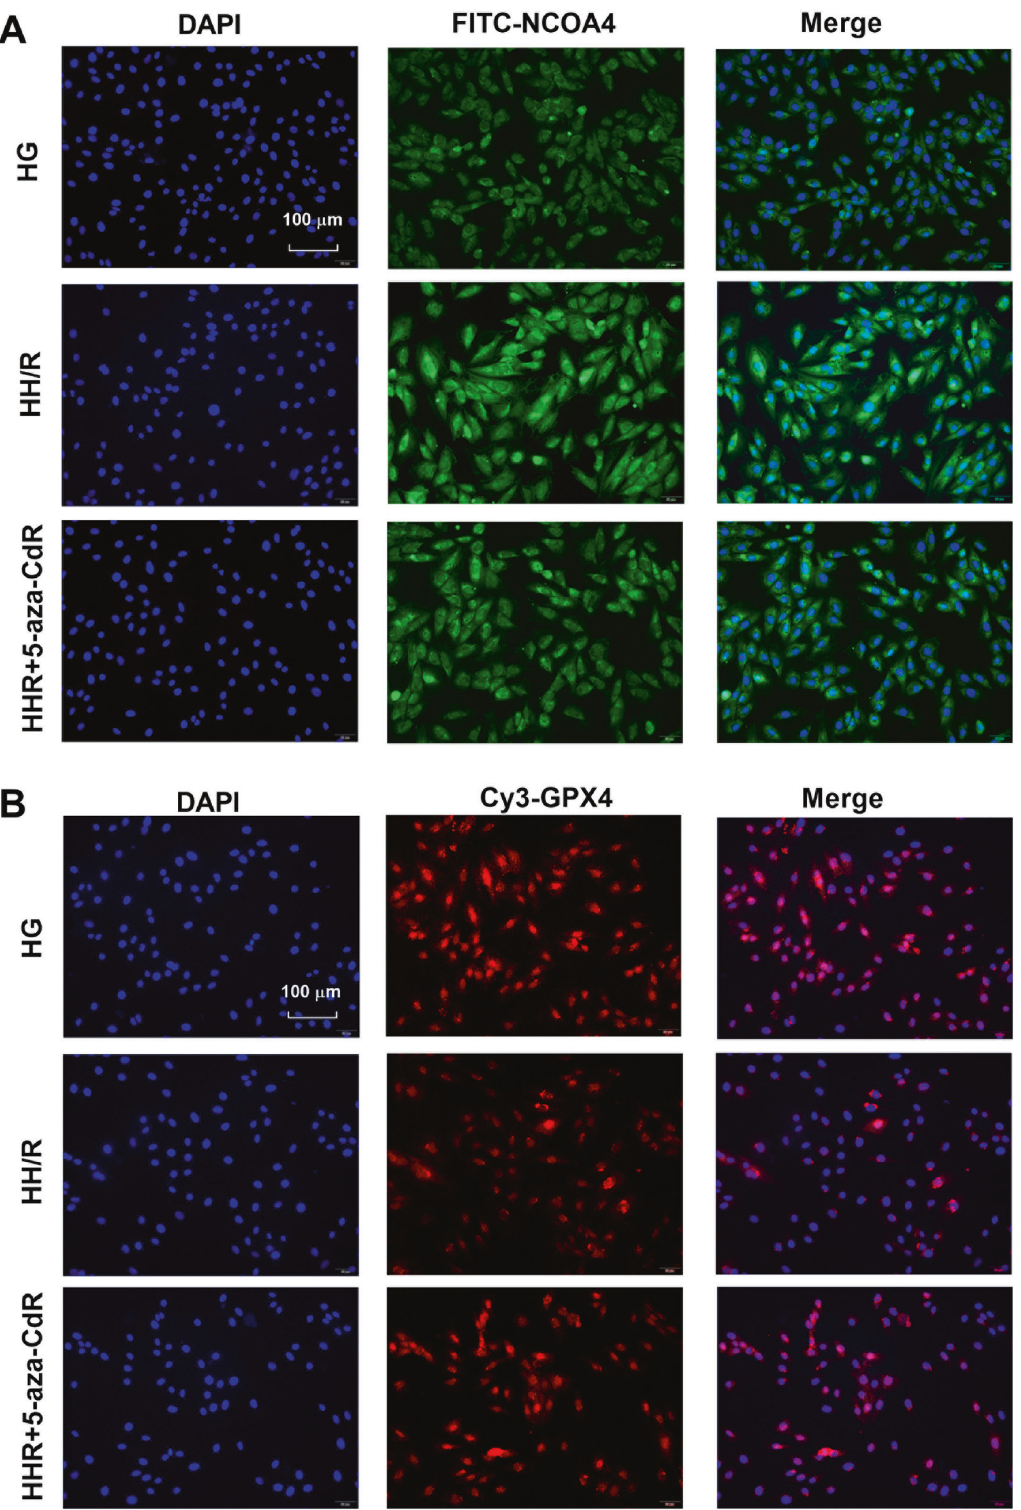
Fig. 7 The expression of NCOA4 and GPX4 was detected by immuno fl uorescence. Effect of DNMT-1 on NCOA4 ( A ) and GPX4 in HH/R H9c2 cells ( B Epigenetics is the science of reversible changes in gene expression and function, and the generation of heritable phenotypes without changing the DNA sequence [36]. DNA methylation is one of the fi rst and most important epigenetic